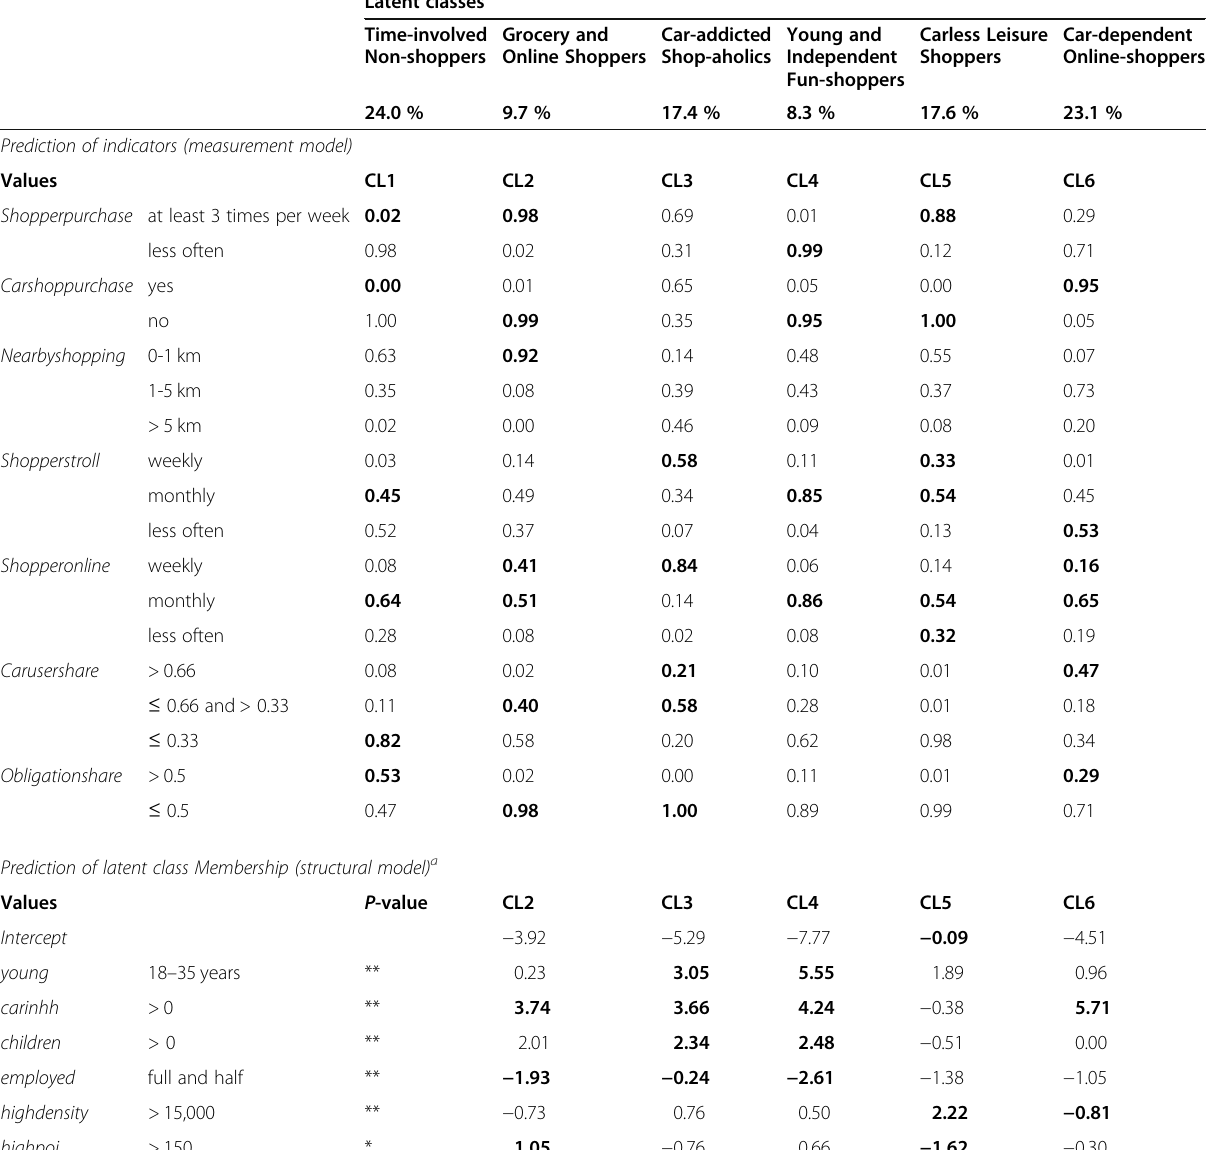
Table 3 Parameters of the LCA model with 6 classes of shopping